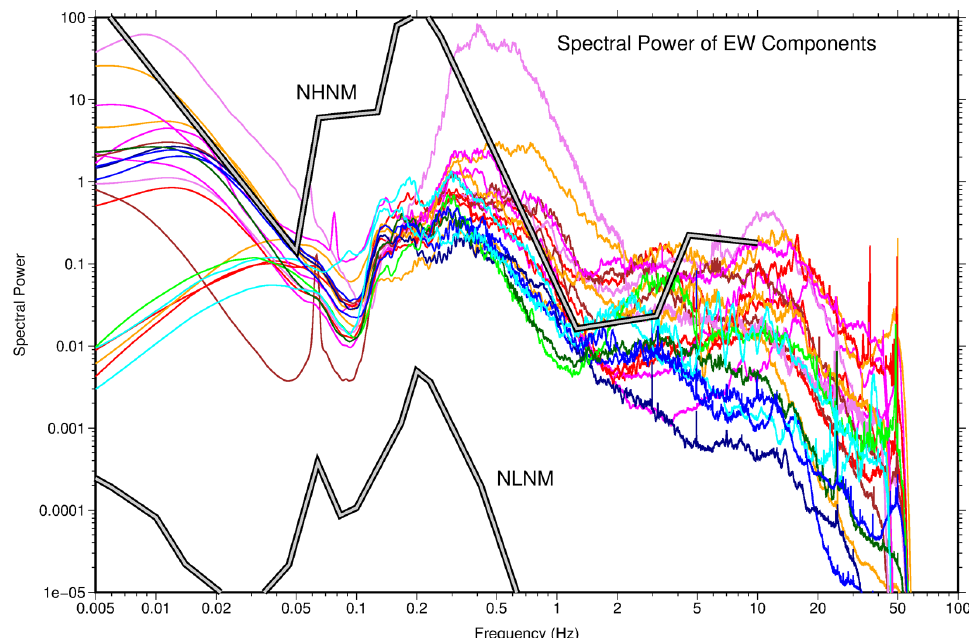
Figure 4. Mean spectral power computed over one month of data at all stand-alone stations currently installed at Campi Flegrei (hot col- ors) and Vesuvius (cold colors). The results of the EW components are shown and compared with the NLNM and NHNM.